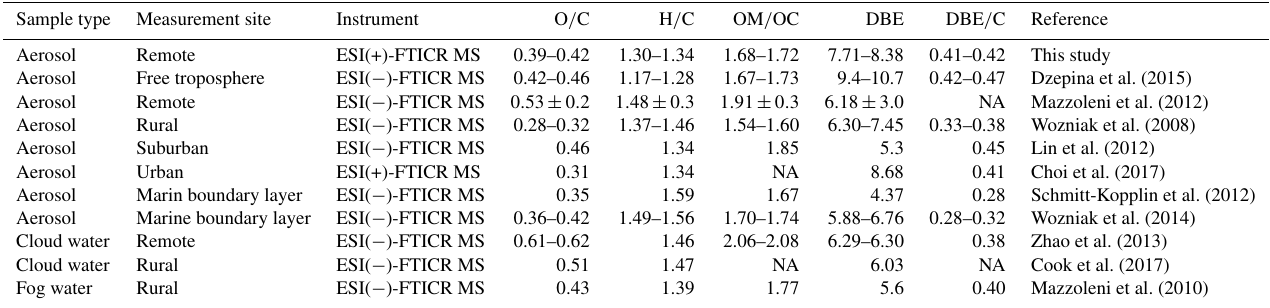
Table 2. Chemical characterization of the molecular assignments detected in aerosol samples from selected studies (adapted and modified from Table 3 in Dzepina et al., 2015). Note that all values are presented as arithmetic means, which are given for convenience of comparison. The data for our study are the arithmetic means for P1 and P2.